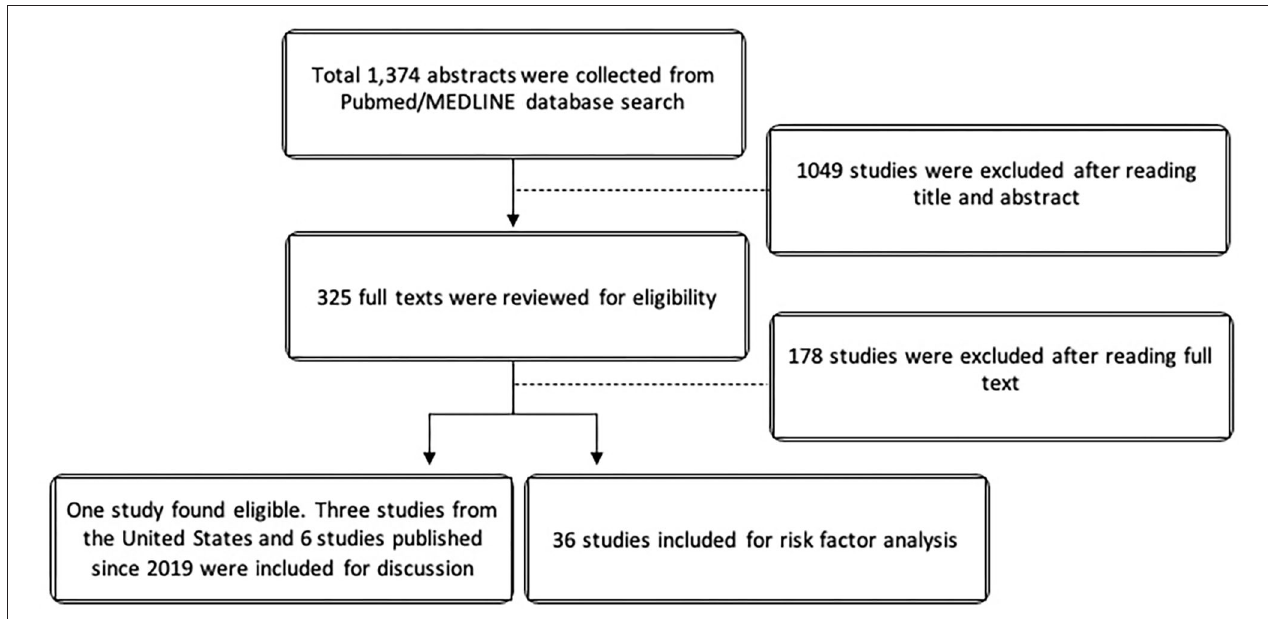
FIGURE 1 | PRISMA flow diagram for literature